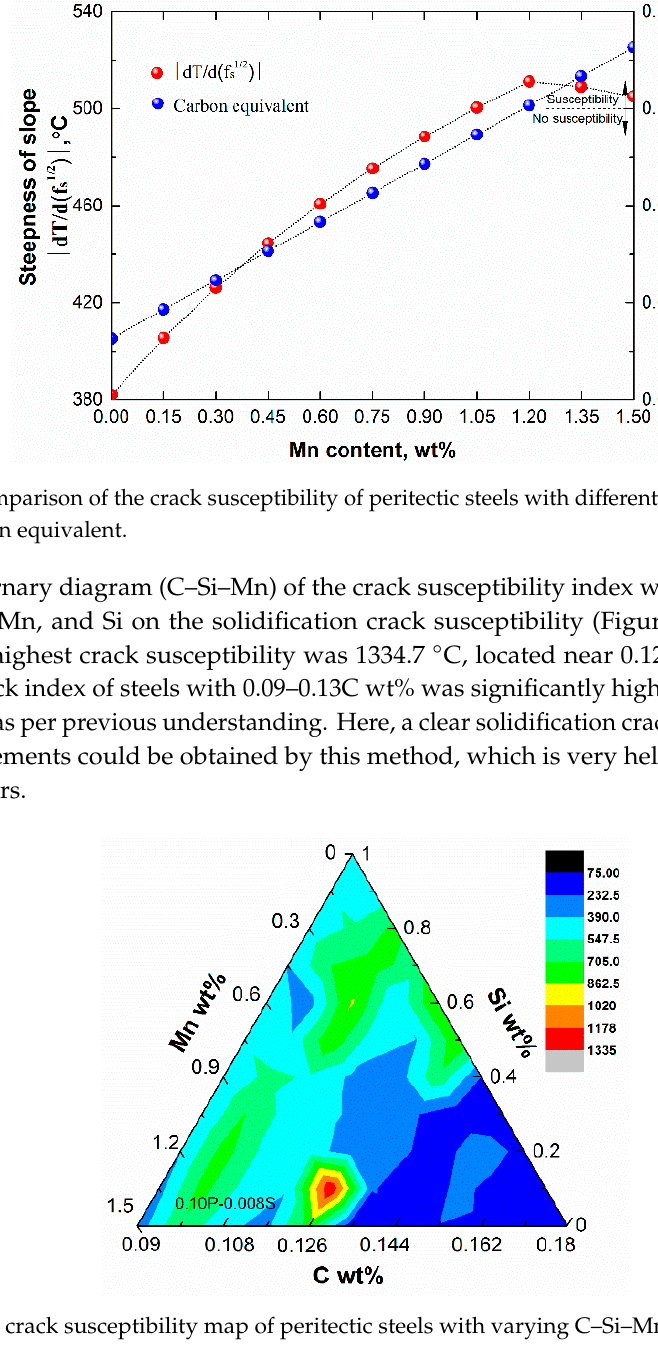
Figure 8. The crack susceptibility map of peritectic steels with varying C–Si–Mn wt.% at the cooling rate of 10 ◦ C/s.